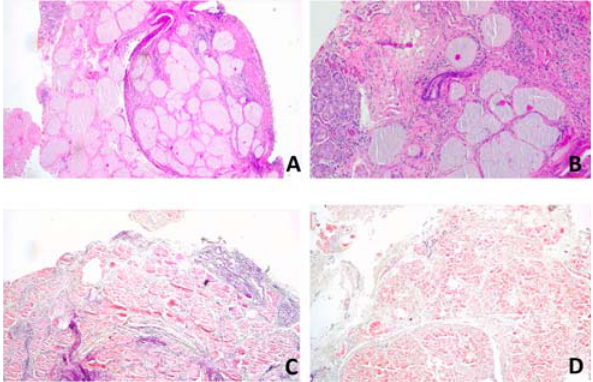
Figure 1: Histological preparation. ( A ) Excisional biopsy of the left vocal cord reveals a deposit of amorphous eosinophilic material in the tissue, consisting of amyloid ( hematoxylin – eosin stain ) . Magni fi cation 4 × . ( B ) Detailed image of amyloid deposits. Magni fi cation 10 × . ( C and D ) Deposits are highlighted on Congo red stain. Magni fi cation 10 ×